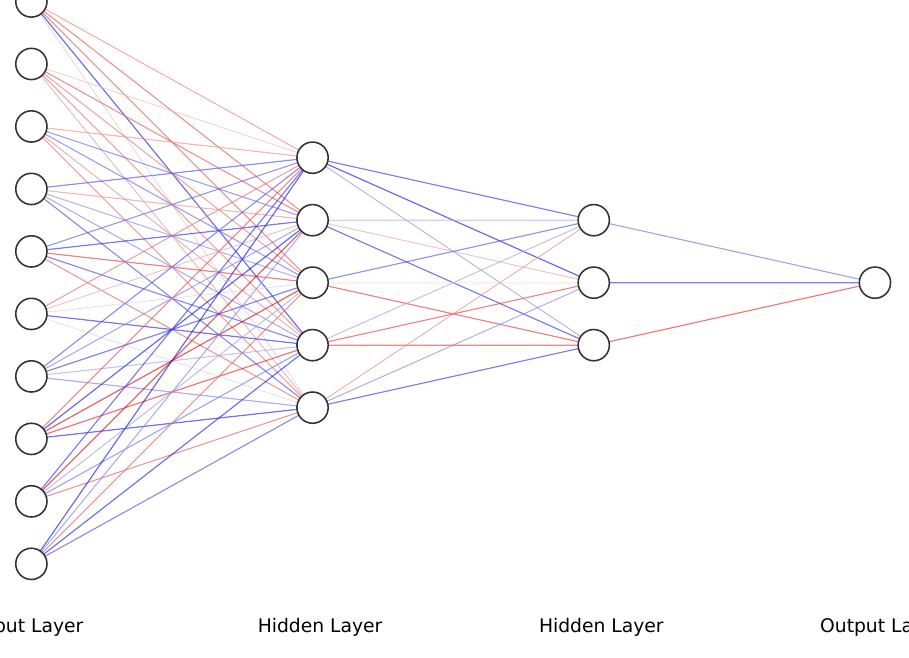
Figure 4. DMLP Neural Network Diagram.